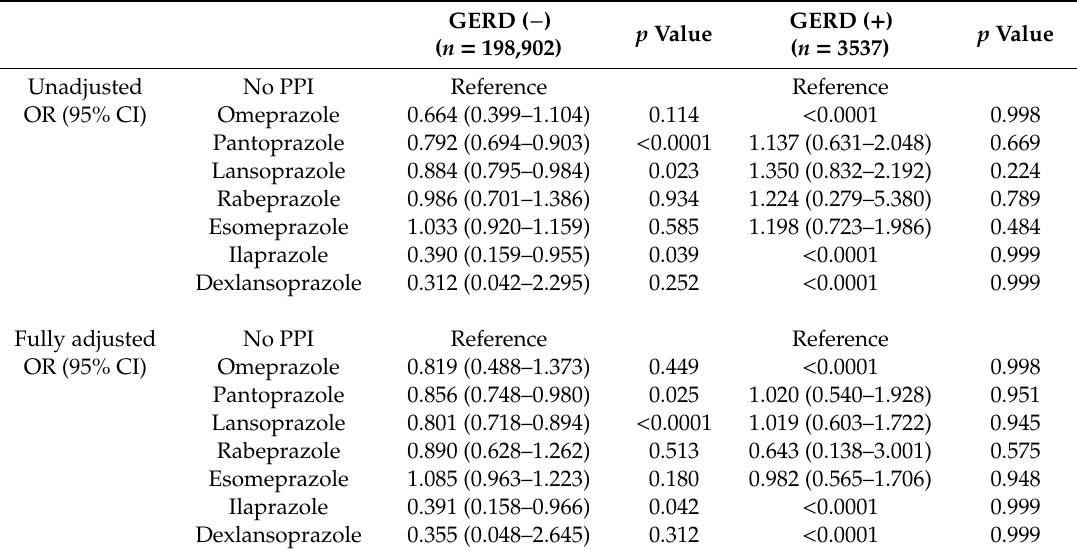
Table 4. Unadjusted and fully adjusted odds ratios for the occurrence of PONV by PPI type according to presence and absence of